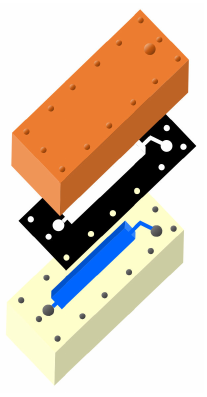
Figure 3. Slit-channel